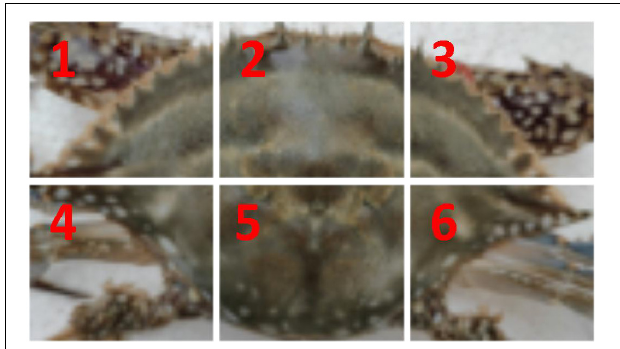
FIGURE 3 | Six-square grids plan on P. trituberculatus . The numbers in the picture indicate the divided parts.